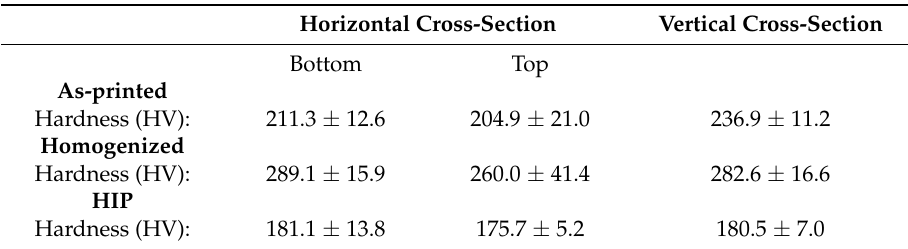
Table 4. Average values of Vickers hardness of the as-printed and heat treated Inconel